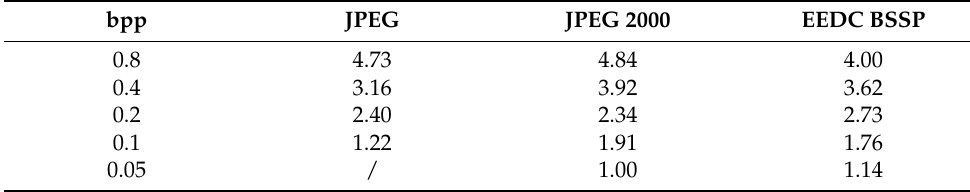
Table 26. MOS values for image pills at various compression